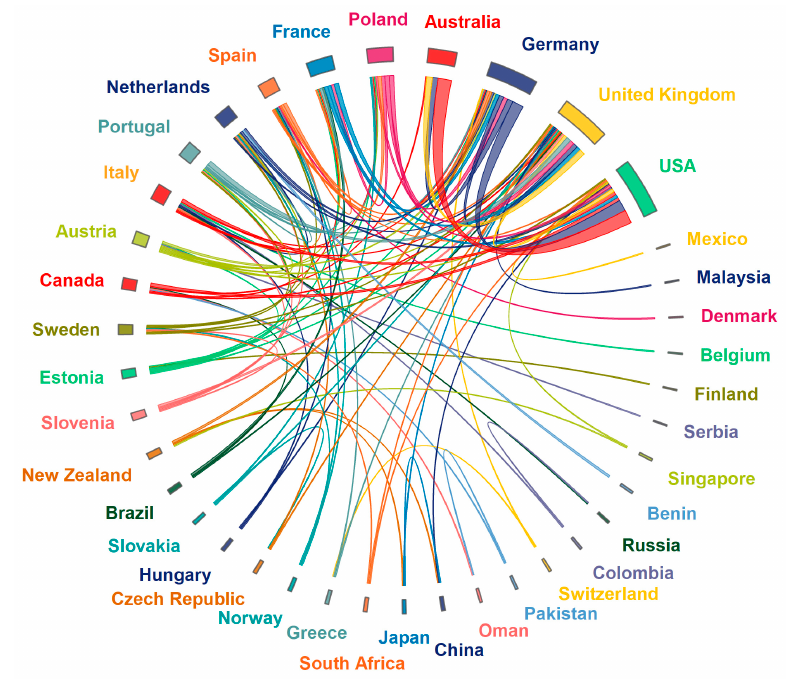
Figure 5. The country/region collaboration network.